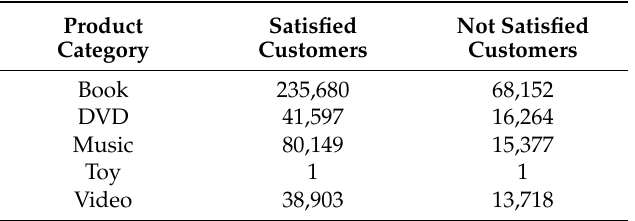
Table 2. Measurement of satisfaction of customers.